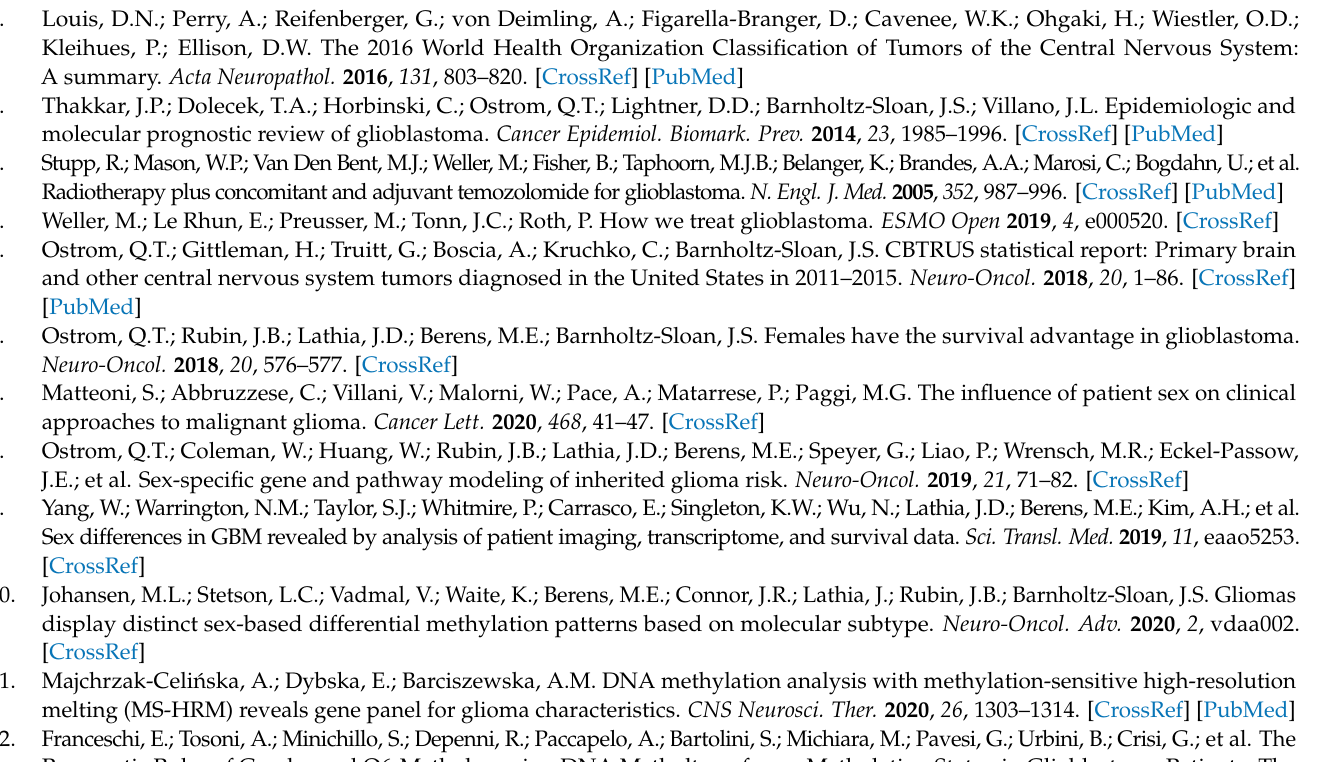
cohort 1. Table S2: Multivariate Cox-regression in females and males in cohort 2. Figure S1a: Survival for men ( n = 151) and women ( n = 106) in 257 TCGA-derived IDH wt GBM with known MGMT status and sex ( p = 0.01, Log-rank). Figure S1b: Survival for men ( n = 116) and women ( n = 73)